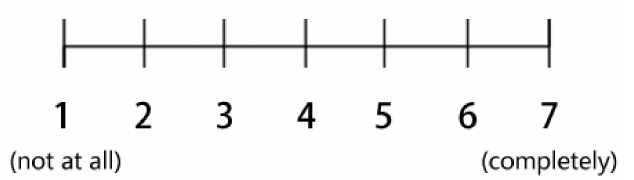
Figure 3. The seven-point scale for degree of soundscape perception.